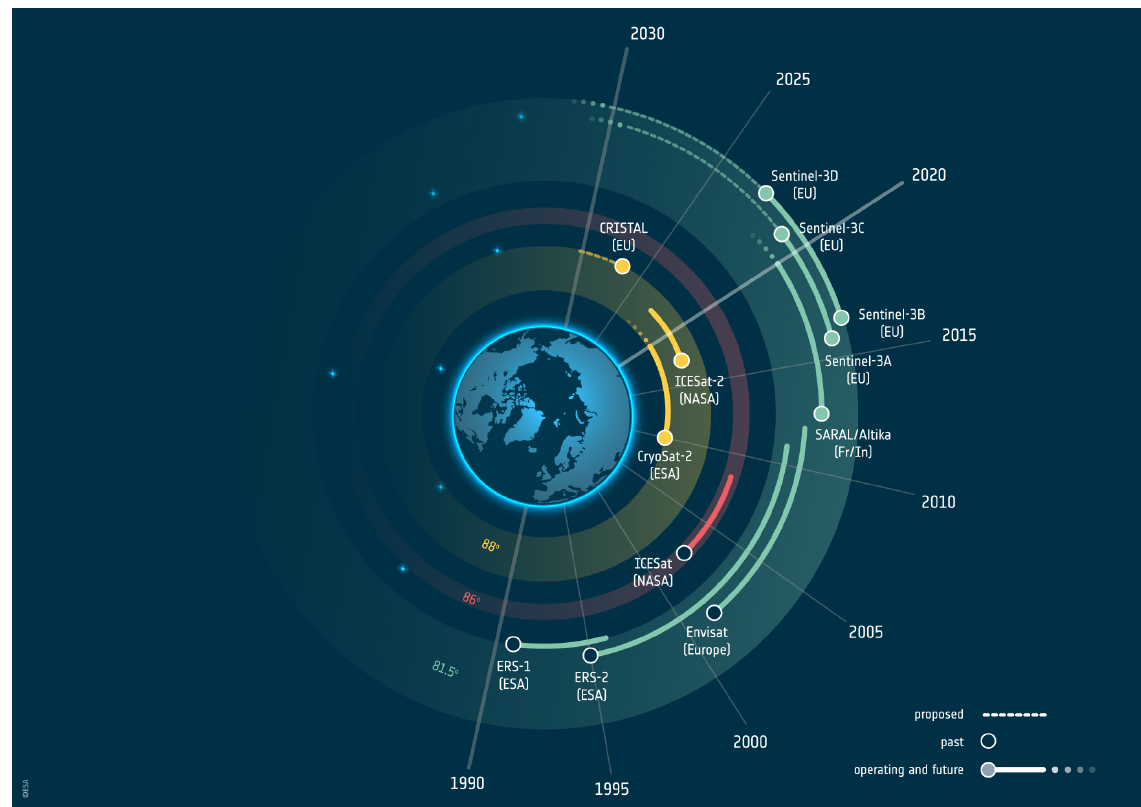
Figure 1. Past, operating, approved, and proposed polar topography altimeter missions. By the mid-2020s, CRISTAL will fill the gap acquiring climate-critical data over polar ice north and south of 81.5 ◦ latitude (image: